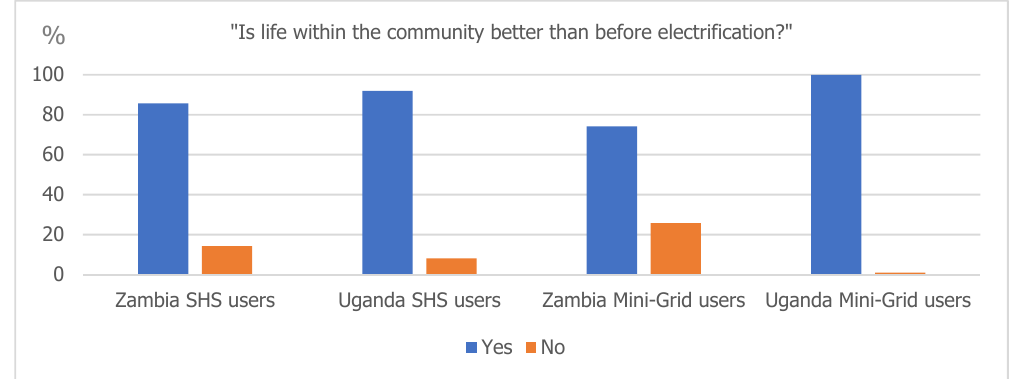
Figure 11. General perceived community impact of electrification on communities in Uganda and Zambia among various subgroups; Responses in %.